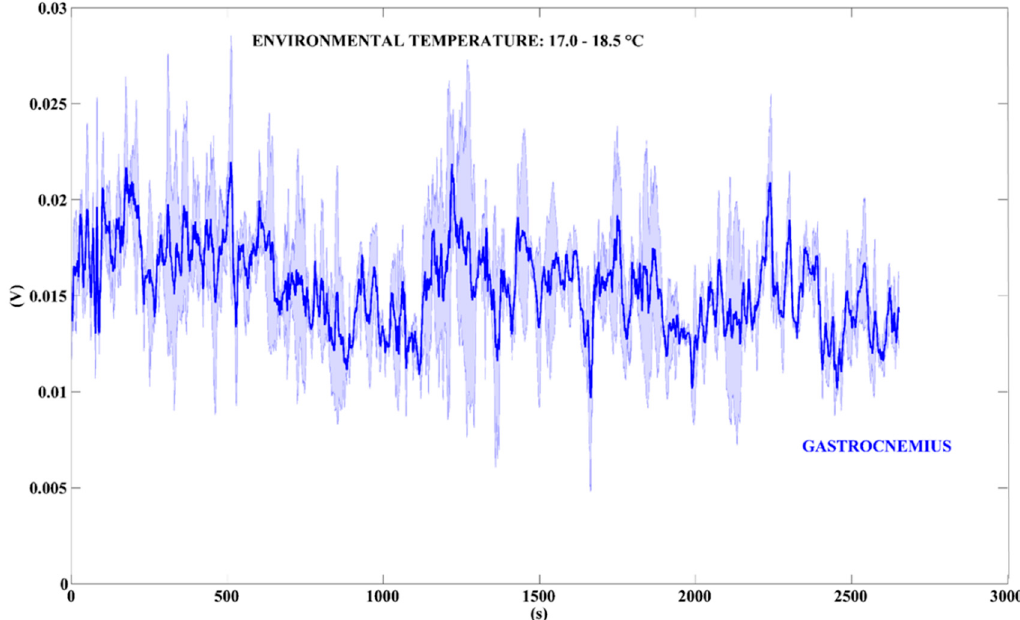
Figure 11. Voltage output signals generated by the TEG. The bold blue line represents the mean value of the TEG placed on the gastrocnemius. The blue area around the bold lines represents the standard deviations (n = 2). Time-interval: 2650 s.